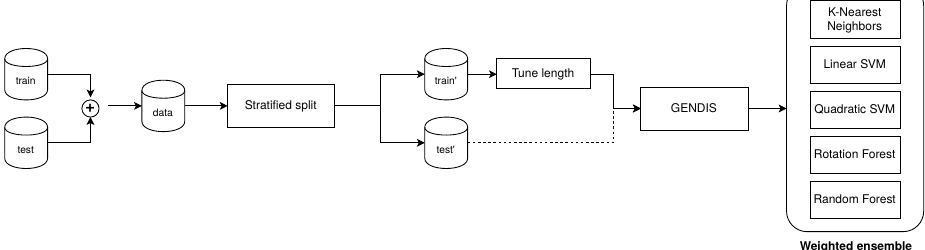
Figure 13. The evaluation setup used to compare gendis to other shapelet